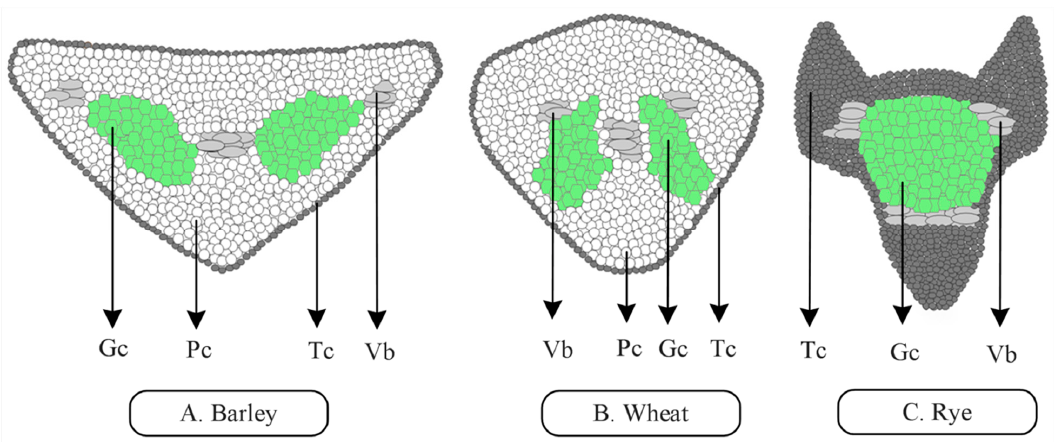
Figure 1. Transverse section shows several cell types. Except for rye lacking parenchyma cells, wheat and barley are similar in most of the cell types despite di ff erences in awn structure. ( A , B ) In transverse sections, barley and wheat awns are triangular and show a high number of parenchyma cells compared to other cell types. ( C ) Rye awns are triangular in transverse section with a high number of green cells and thick-walled cells compared to other cells. Gc, green cell; Pc, parenchyma cell; Tc, thick-walled cell; Vb, vascular bundle.